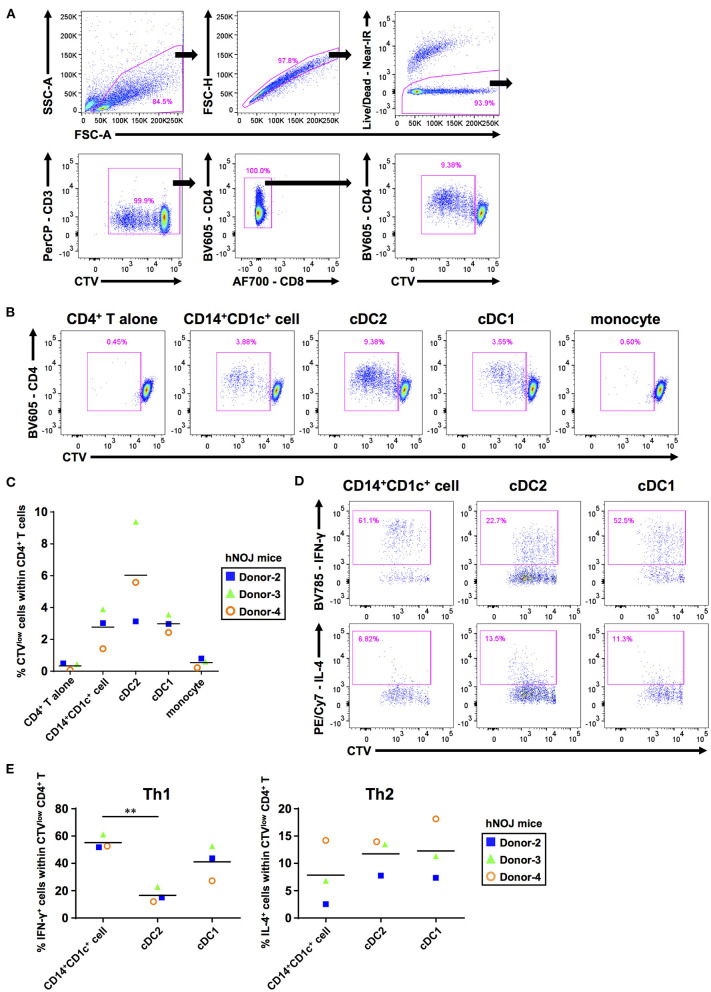
The ability to prime and polarize Th cells among human dendritic cell populations derived from hNOJ mice. DCs and monocytes were isolated from pooled spleens of donor-matched hNOJ mice following IVT, and CD4+ T cells were prepared from allogeneic human peripheral blood mononuclear cells. CD4+ T cells were subjected to flow cytometric analysis following co-culture for 5 days with DCs or monocytes. (A) A representative gating strategy for CD4+ T-cell proliferation. (B) Representative flow cytometry profiles of CD4+ T-cell proliferation based on the CellTrace Violet (CTV) intensity in each co-culture condition. (C) Individual percentages of CTVlow cells within CD4+ T cells. The same color symbols show the same donor-derived hNOJ mice. The repeated-measures one-way ANOVA followed by the Holm-Sidak's multiple comparison test was used to compare among co-culture conditions, and no significant differences were observed. (D) Representative flow cytometry profiles of IFN-γ and IL-4 expression in CD4+ T cells. (E) Individual percentages of IFN-γ+ cells (Th1; n = 3) and IL-4+ cells (Th2; n = 3) within CTVlowCD4+ T cells. The same color symbols show the same donor-derived hNOJ mice. Significant differences (**P < 0.01) were determined using the repeated-measures one-way ANOVA followed by the Holm-Sidak's multiple comparison test.